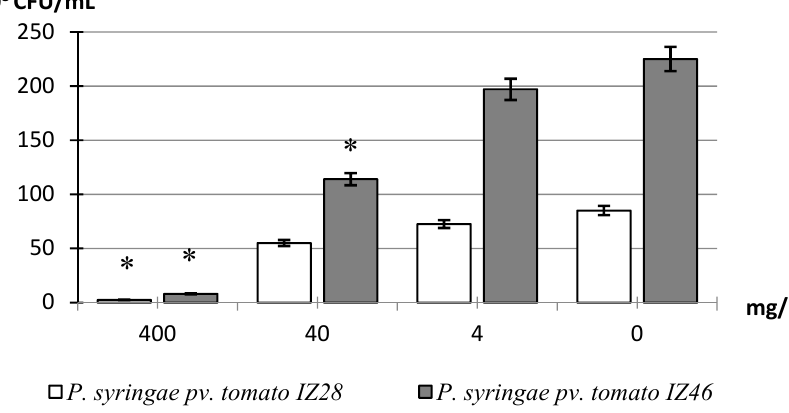
Figure1. E ff ectofaluminiumphosethylonthegrowthof P.syringae pv. tomato : *—Statisticallysignificant Figure 1. Effect of aluminium phosethyl on the growth of P. syringae pv. tomato : *—Statistically di ff erences between the control and a variant of the experiment at level p ≤ 0.05; significant differences between the control and a variant of the experiment at level p ≤ 0.05; “0”—control.